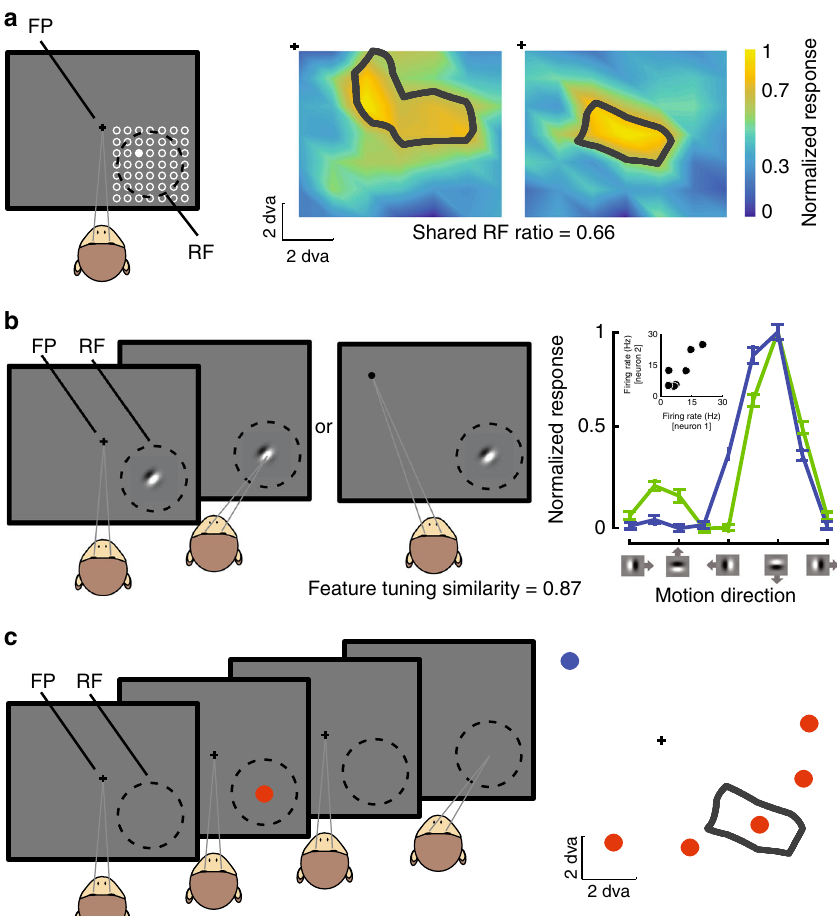
Fig. 1 Paradigms for measuring spatial RF, feature tuning, and WM modulation. a Spatial RF mapping during fi xation and quantifying RF overlap between neurons. In the RF mapping task, the monkey fi xates in the center of the screen while probes fl ash in a grid covering the estimated RF location. For each neuron, an RF pro fi le is constructed based on locations in which probe-evoked activity is at least 50% of the maximum probe-evoked response. The RF overlap between two neurons is measured using the formulas in the Methods: Data analysis (the sample pair ’ s shared RF ratio = 0.66). b Visually guided saccade task for measuring motion direction tuning. The monkey fi xates and a moving grating stimulus appears in the neuron ’ s RF; the grating can be moving in one of eight directions. When the fi xation point disappears, the monkey saccades either to the grating stimulus, or to a saccade target which appears in the opposite visual hemi fi eld. To calculate the similarity in feature tuning between two neurons, we measured the correlation coef fi cient for the average fi ring rate of the two neurons in response to the eight motion directions (Tuning curves of the same sample pair to the right; inset scatter plot, Pearson correlation coef fi cient = 0.87). c Memory guided saccade task. The monkey fi xates, and a cue stimulus appears in one of six positions arranged around the neuron ’ s RF location. The cue stimulus disappears, and the monkey maintains fi xation throughout a blank delay period. Following the disappearance of the fi xation point, the monkey saccades to the remembered location to receive a reward. An example MT neuron ’ s RF (black contour) and the relative positioning of the MGS target locations (gray dots) are shown to the right; we frequently compare activity or correlations during memory IN condition (red dots) vs. memory OUT (blue dot). Cross indicates fi xation (the cross-section of the RF along the shared dimension, x axis in a moving peak of activity in a bump attractor model of memory this case), indicating that the WM target is presented near the maintenance. Given that prefrontal projections to visual cortex peak of both neurons ’ RFs. For a pair of neurons like this, with contain information about the content of spatial WM 14 , we very similar RF pro fi les (overlapping pairs), the different WM predicted that a similar dependence of shared variability on the locations will either fall within the Peak (both responses >70% of similarity of spatial tuning and memory location would be evi- maximum), Flanks (both responses 30 – 70% of maximum), or dent in MT responses. Indeed, splitting neuron pairs based on Tails (both responses <30% of maximum) of the RF pro fi les, as their shared spatial sensitivity revealed that the ability of a WM schematically illustrated in Fig. 2b. The effect of WM on the signal to alter the correlation between a pair of neurons depends correlation between this pair of neurons depends on whether the on the degree to which those neurons are sensitive to the location WM location is in the Peak, Flanks, or Tails location. Even held in WM. Figure 2 illustrates the effect of WM on the corre- though the fi ring rate is not altered by WM, we still performed a lations between two example MT pairs with differing degrees of rate-matching control when calculating the correlation values (see similarity in their spatial sensitivity. The inset in Fig. 2a shows the Methods: Data analysis). All correlation changes are reported as contour of the RFs for two simultaneously recorded MT neurons. the change compared to the Memory OUT condition. For this These are the same two neurons shown in Fig. 1, with a shared RF pair of MT neurons we observed a signi fi cant increase in the ratio of 0.66. As shown, the WM location is within the RF of both correlation between their responses when the locus of WM is at of these neurons. Figure 2a shows the RF pro fi les of these neurons